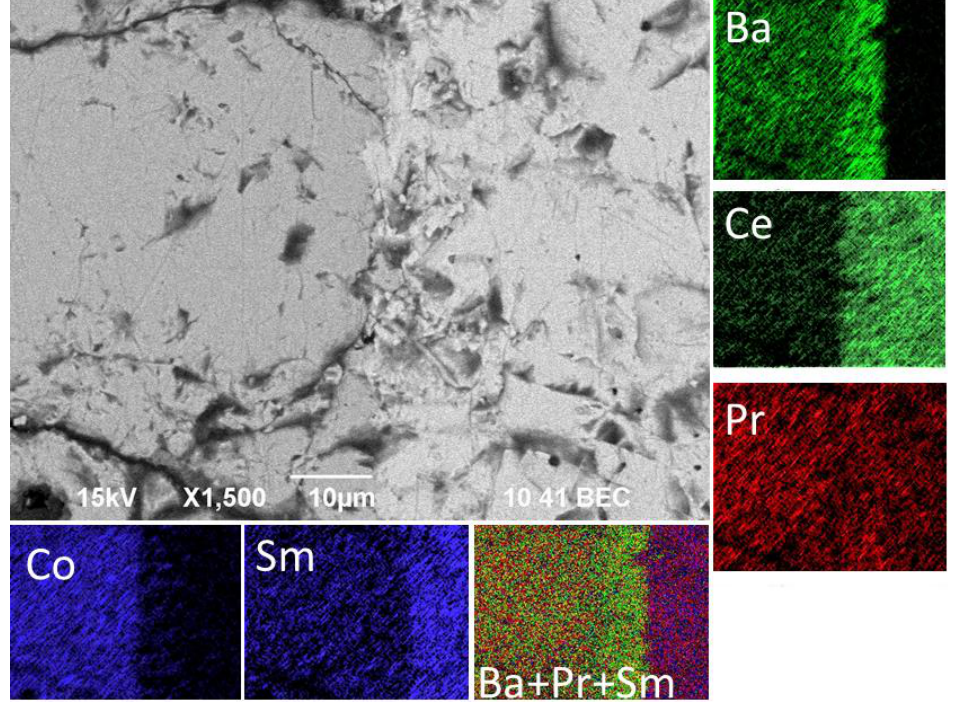
Figure 5. SEM micrograph of the cross-section of the PBC-SDC diffusion couple annealed at 1000 °C for 30 h in air and element maps.